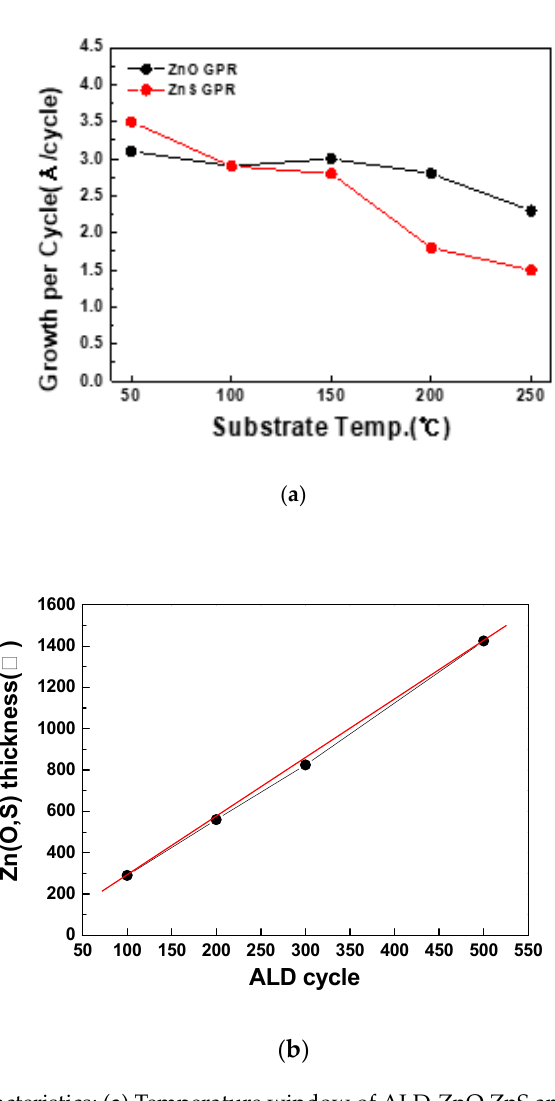
Figure 1. Growth characteristics; ( a ) Temperature window of ALD-ZnO,ZnS and ( b ) typical example showing the film thickness as a function of the number of ALD cycles.